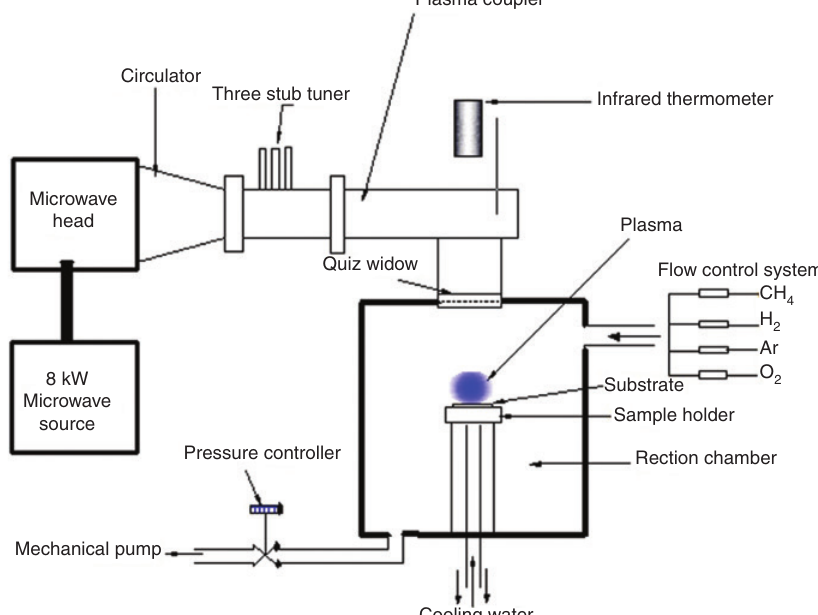
Figure 1: Schematic diagram of MPCVD system.